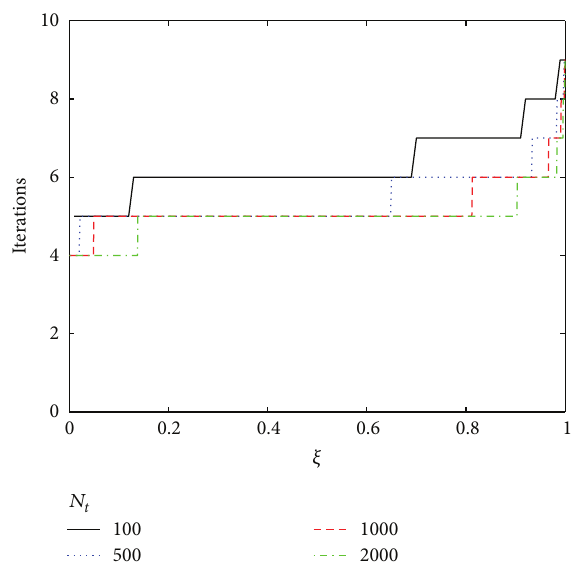
Figure 3: Variation of the SRM iterations with time 𝜉 in Example